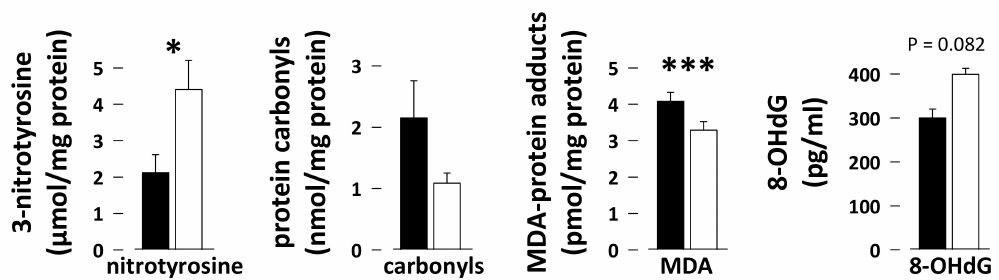
Figure 4. Oxidative damages in bear skeletal muscle. Levels of 3-nitrotyrosine, protein carbonyls, malondialdehyde(MDA)-proteinadducts, and8-hydroxy-2-deoxyGuanosine(8-OHdG)weremeasured using commercial ELISA kits in vastus lateralis muscle samples from summer-active (black bars) and hibernating (white bars) brown bears. Data (N = 5–7 / group) are expressed as means ± sem. Statistical significance is shown for paired student t -tests (* p < 0.05; *** p <